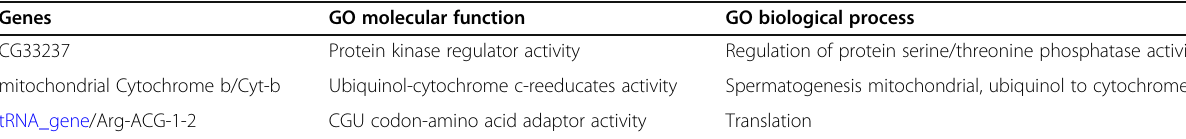
Table 4 GO terms for motif Mtrn I